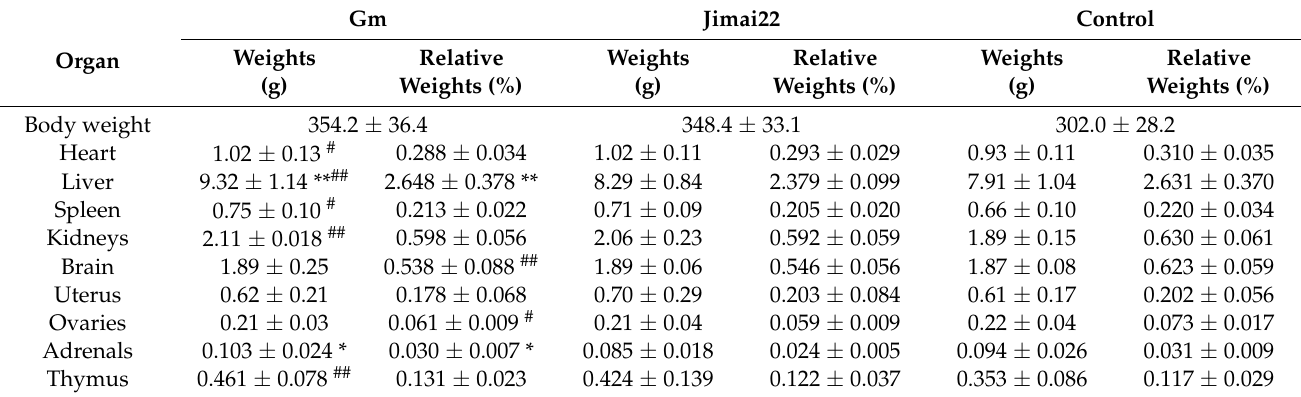
Table 3. Organ weights and relative organ weights of females ( x ± s, n = 20).